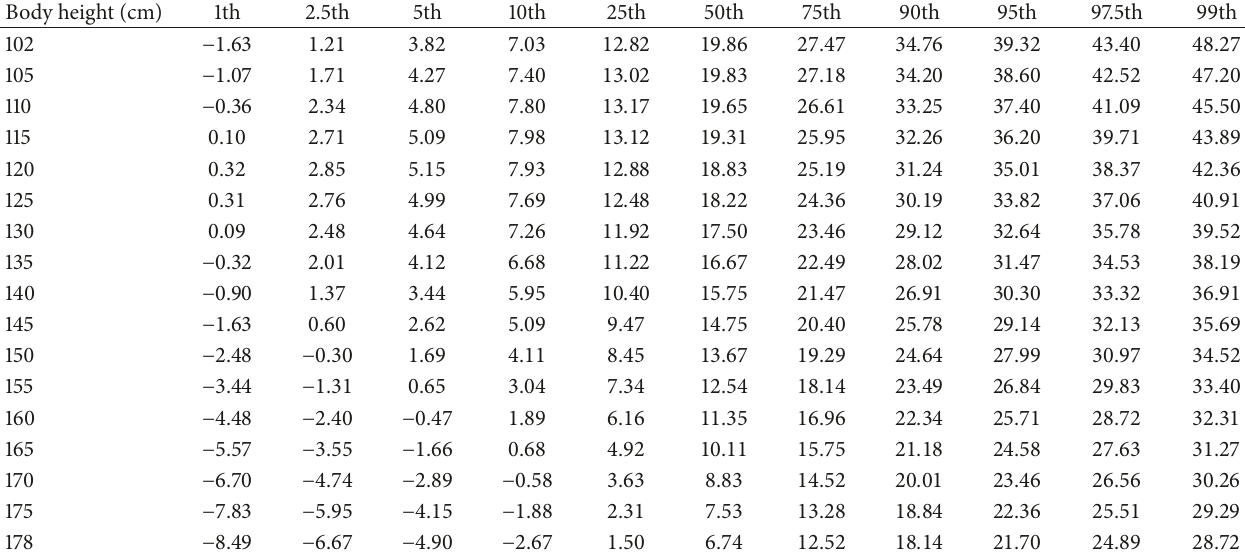
Table 11: Body height-related reference intervals (RIs) for central (aortic) augmentation index (cAIx) for females ( 𝑛 = 462 ). Body height